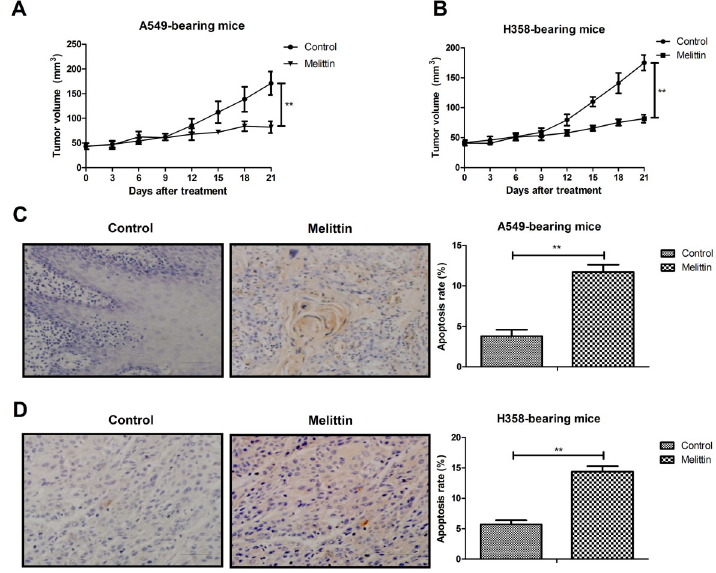
Figure 4. In vivo ef fi cacy of melittin for non-small-cell lung cancer cells (A549 and H358) in a xenograft mouse model. A and B , Melittin (5 mg/kg) administration inhibited tumor growth. C and D , Melittin administration increased percent of apoptosis in tumor tissues (scale